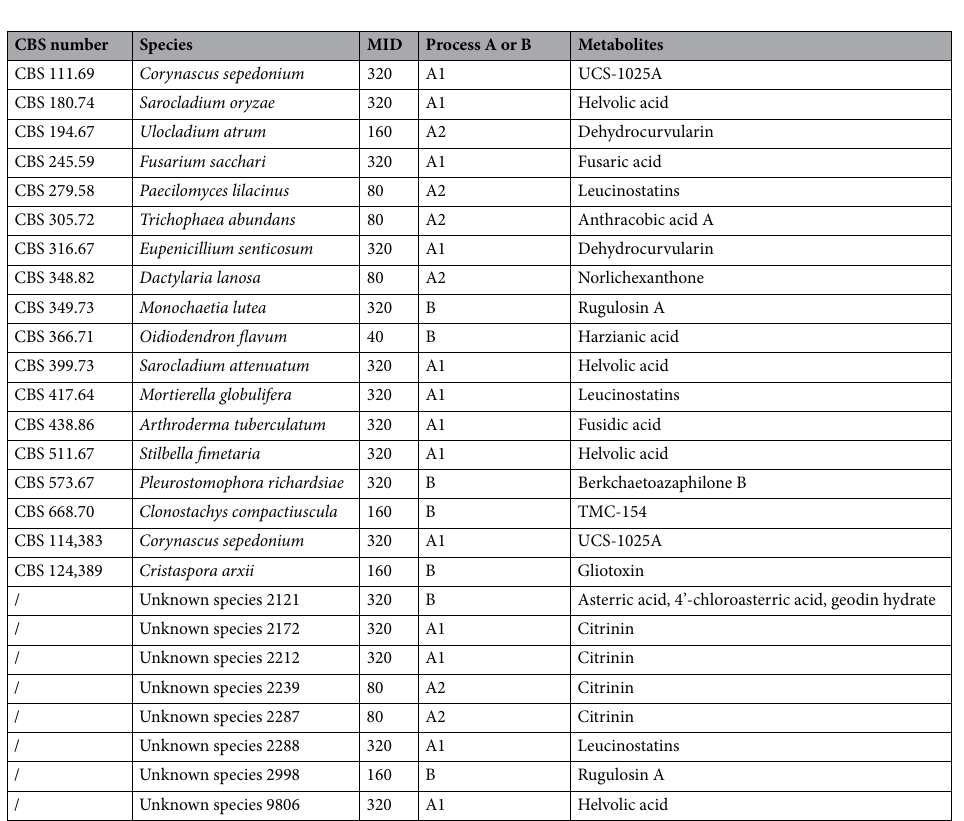
Table 1. Fungal stains with identified metabolites. The 26 selected fungal strains with identified activities are listed. The initial activity of their fungal liquid–liquid extracts (in maximum inhibitory dilution, MID) and the identification process that was used (A1 means from Process A without culturing optimization; A2 means Process A with culturing optimization; and B means from Process B) were also present. The strains without CBS numbers were a gift from the Westerdijk fungal biodiversity